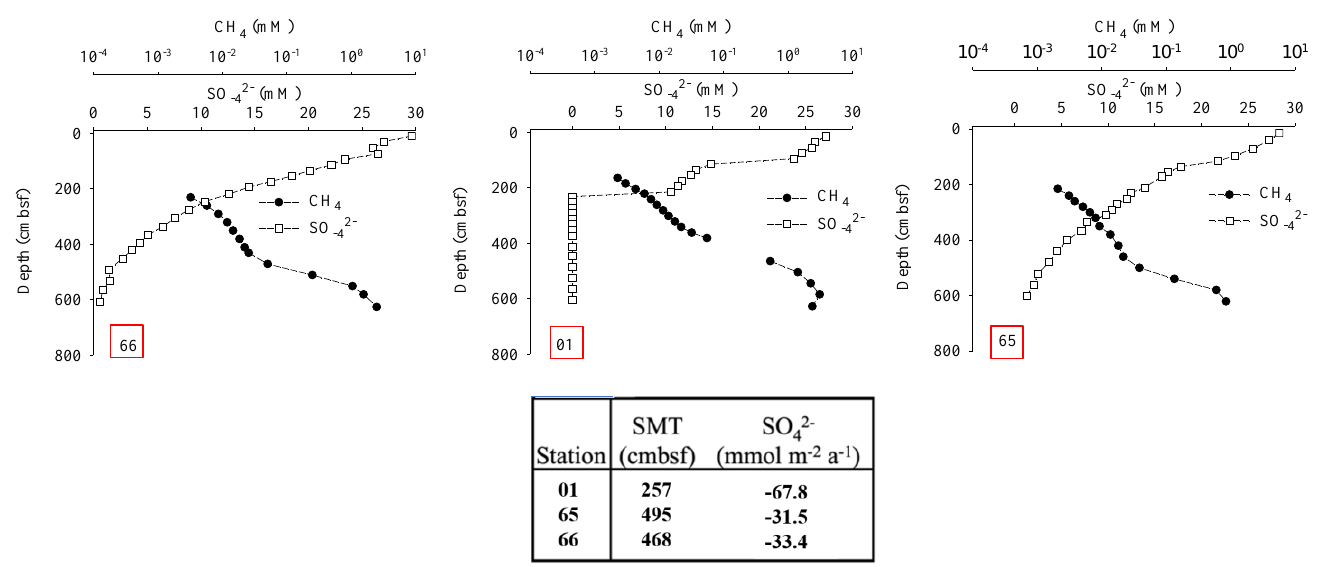
Figure 3. Geochemical data from the Control Site. Piston core numbers presented in seismic profile (Figure 2) are indicated in red boxes. See Figure 1b for geographical locations and Figure 2 for locations on TOPAS and seismic data. Geochemical data include sediment CH 4 and porewater SO 42 − concentrations. “cmbsf” = cm below seafloor. Table shows the sulfate–methane transition zone (SMT), determined from the SO 42- concentrations.